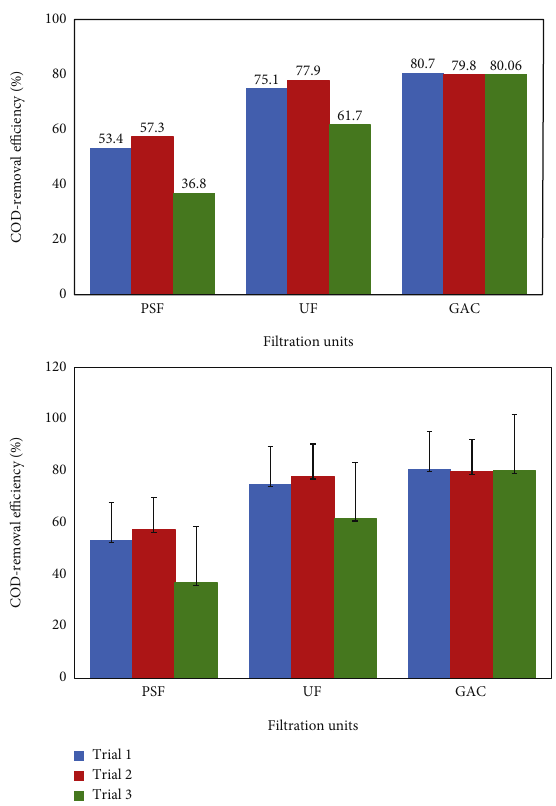
Figure 6: Bar chart representing the removal e ffi ciency of pollutants in PSF, UF, and